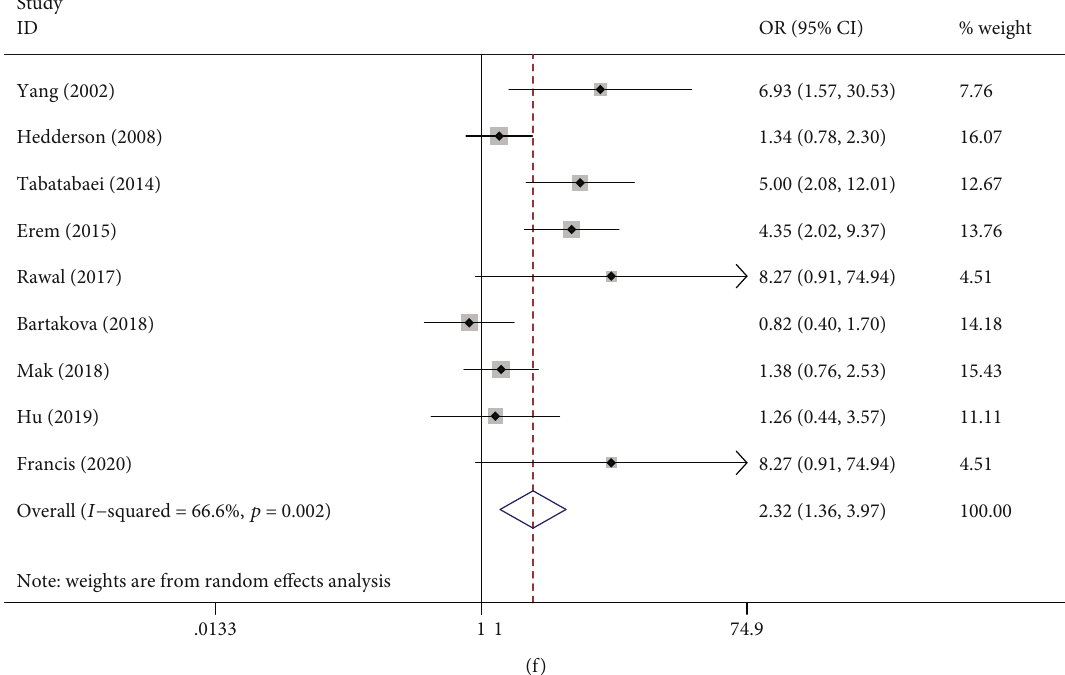
Figure 2: Forest plot for factors associated with GDM: (a) maternal age ≥ 25 years ; (b) prepregnancy overweight or obese; (c) FHD; (d) history of GDM; (e) HIV status; (f) pregestational